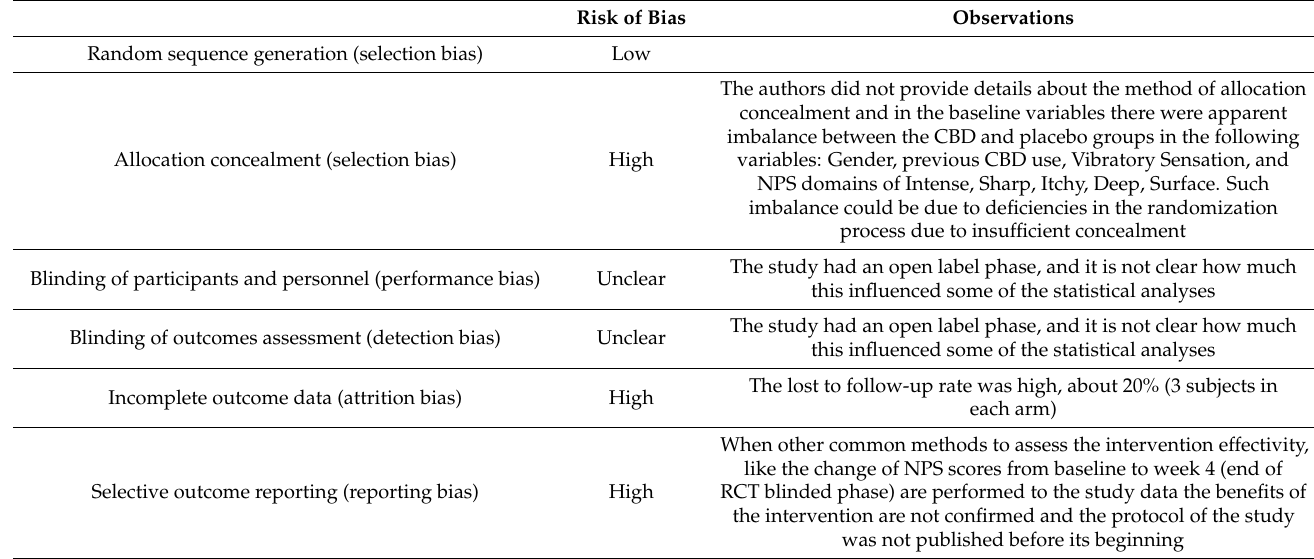
Table 3. Cochrane Risk of Bias for Randomized Controlled Trials Tool for the study selected